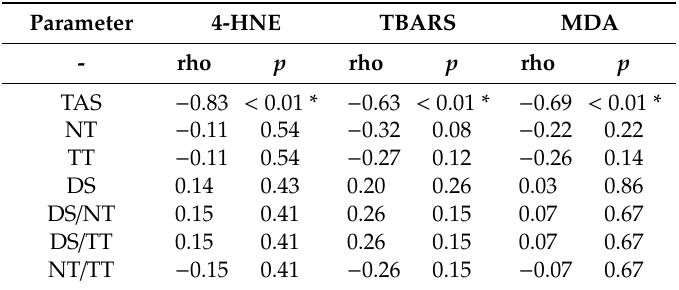
Figure 3. The correlation between the serum levels of malondialdehyde (MDA) and TAS in LP patients. Table 5. Correlations between thiols and pro-oxidant